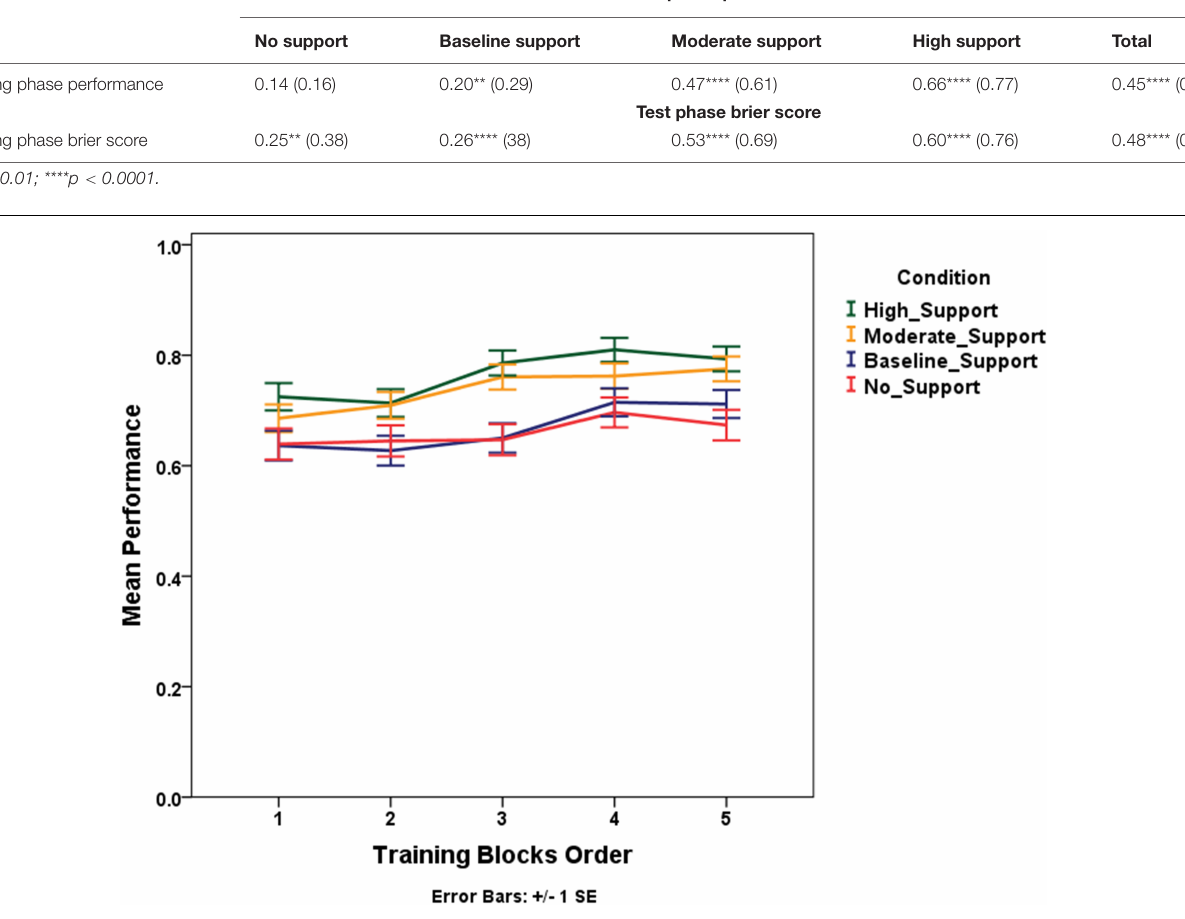
FIGURE 10 | Mean performance (proportion correct) trend for subsequent training blocks across